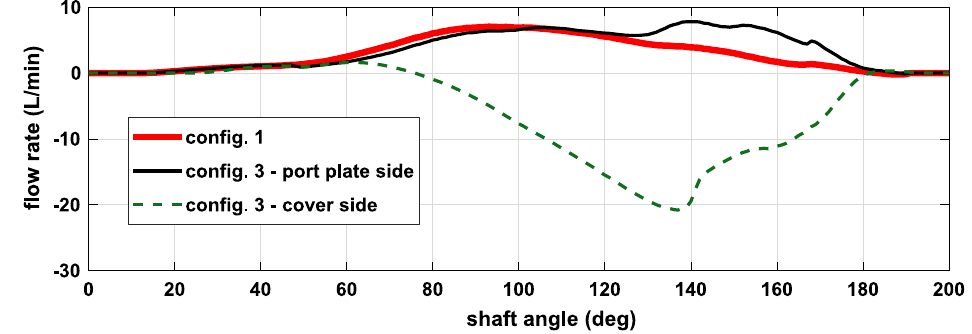
Figure 8. Radial flow rate through the millings on the stator.